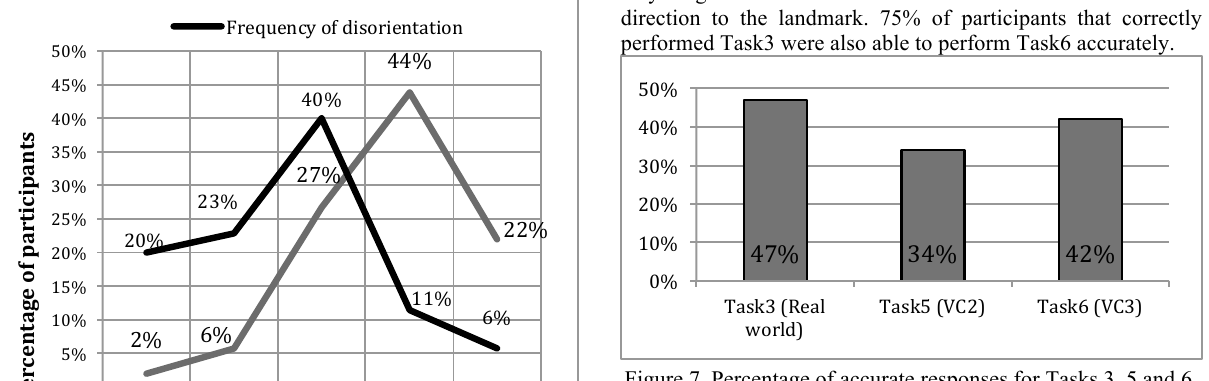
Figure 7. Percentage of accurate responses for Tasks 3, 5 and